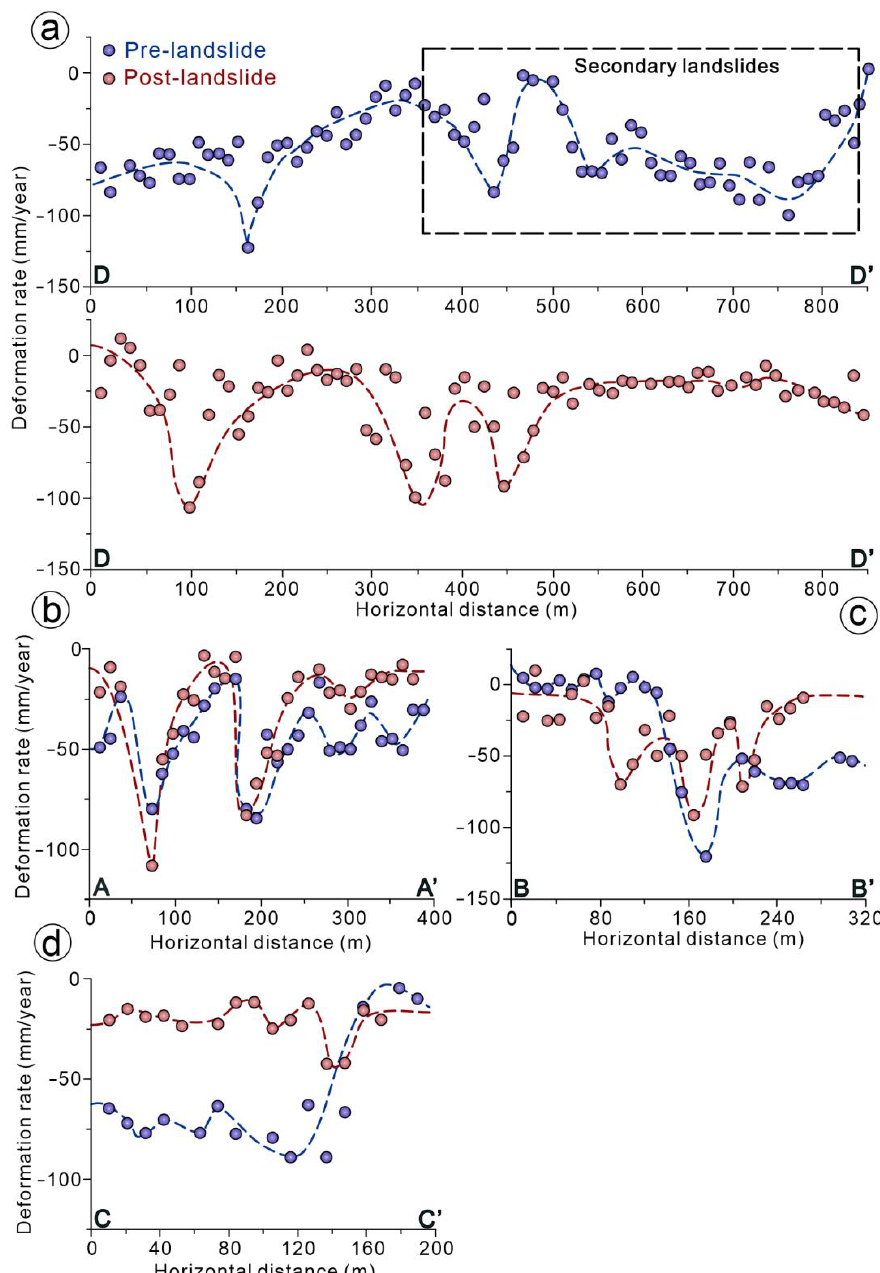
Figure 8. Line-of-sight (LOS) deformation rate before and after the landslide. ( a ) Along the longitudinal (D –D’) . ( b – d ) Along transverse profiles (A –A’, B–B’ and C–C’) . The landslide occurred during the 2018 rainy season. Before the landslide, the dis- placement exhibited a linear trend (Figure 9a). After the landslide, the displacement pro- cess showed alternating slow deformation stages and accelerated deformation stages (Fig- ure 9b). This phenomenon reflects that the looser the structure of landslide soil, the more severely the deformation of the landslide responds to rainfall. The process of the landslide seriously damaged the internal structure of the slope, caused the cracking of the rock and